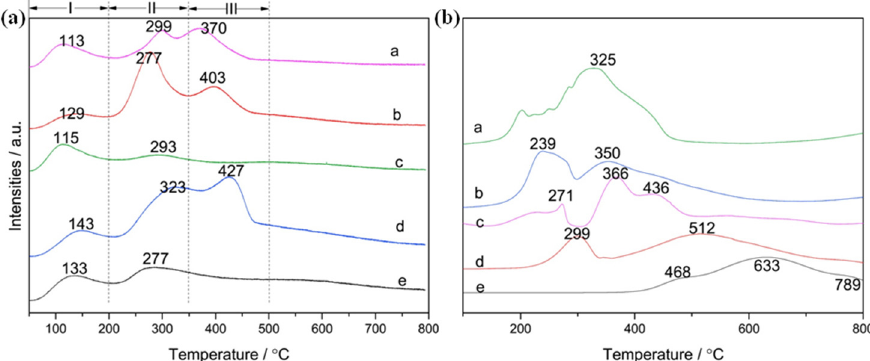
Figure 5. Characterization of the catalysts: ( a ) CO 2 -TPD and ( b ) TPR profiles of a: Ni/Ce-p, b: Ni/CeAl-p, c: Ni/CeAl-c, d: Ni/Al-p, e: Ni/Al-c. Reprinted with permission from [120]. Copyright 2015